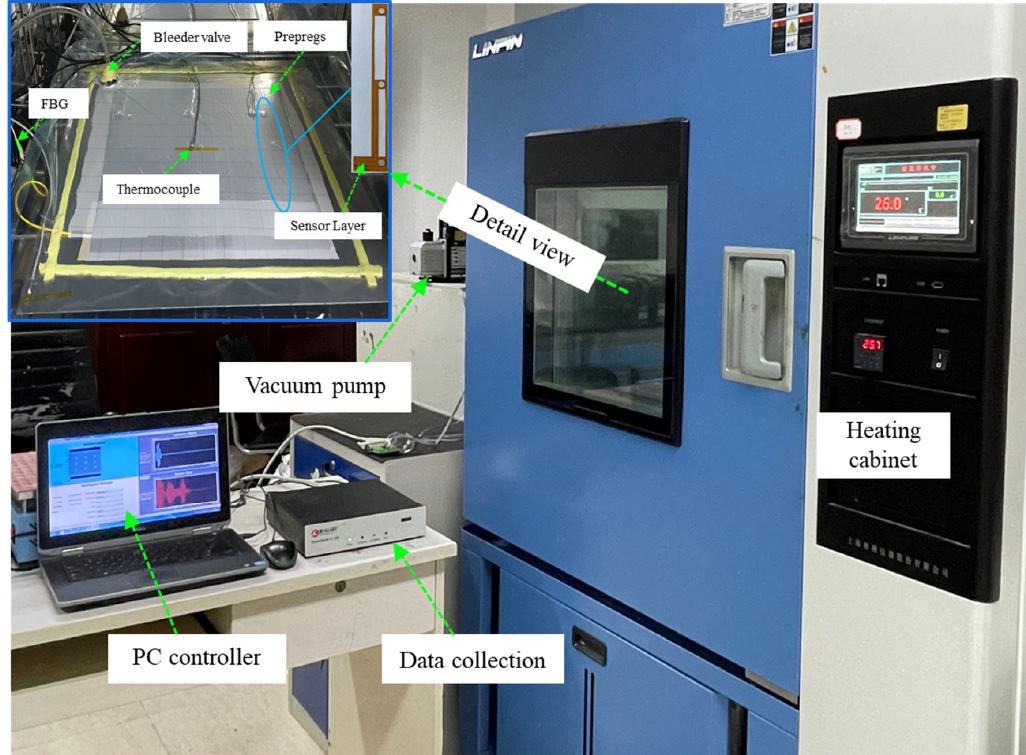
Figure 2. The schematic of the experiment platform for cure monitoring. Table 1. The characteristic properties of circular PZT sensors. Items.